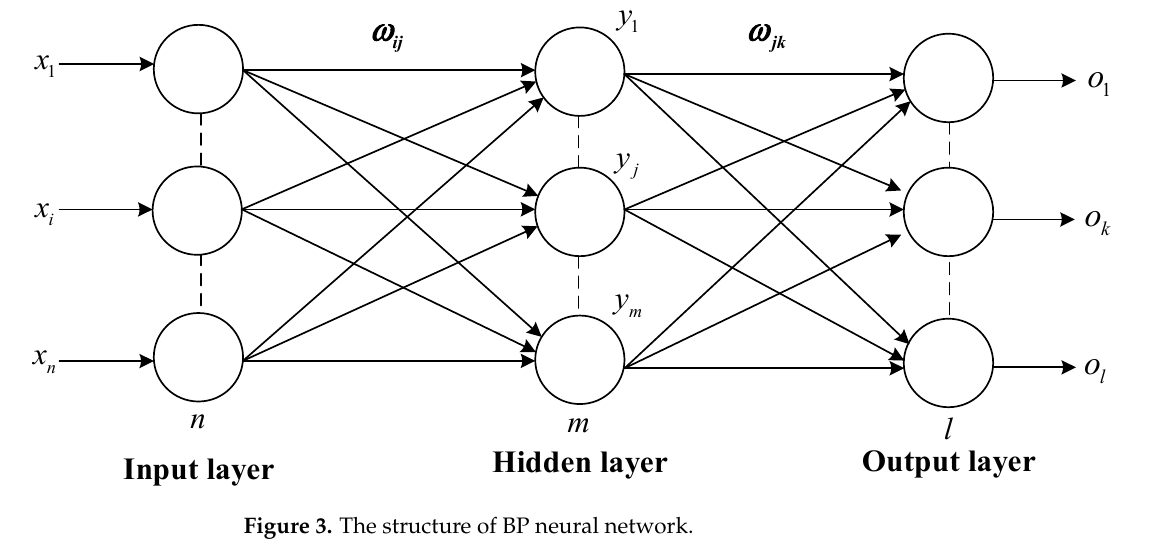
Figure 3. The structure of BP neural network.